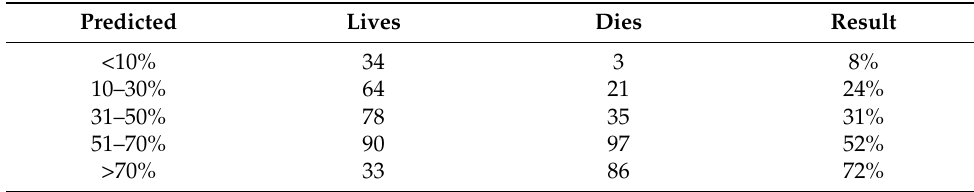
Table 4. Characteristics of the validation study.